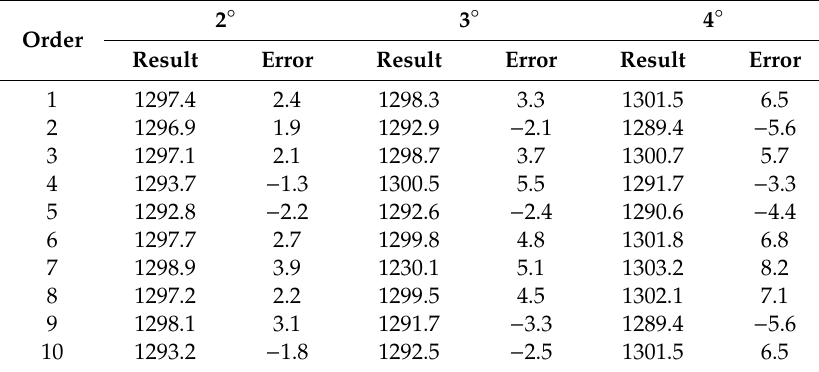
Table 2. Measurement results (unit: mm).